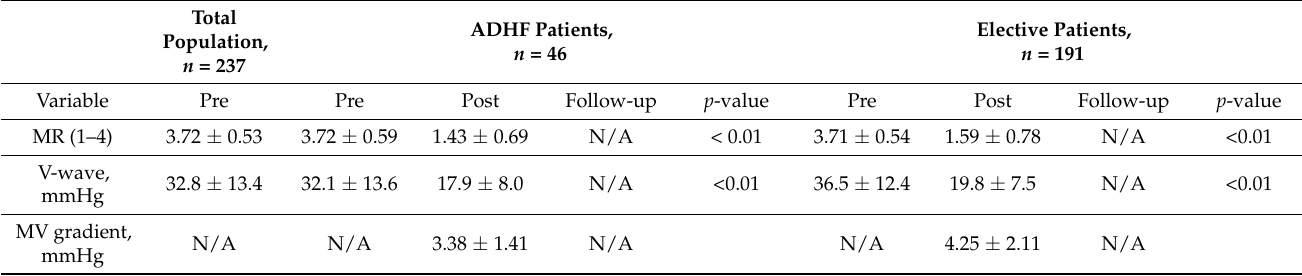
Table 4. Hemodynamic and echocardiographic characteristics of patient population with severe MR before and immediately after